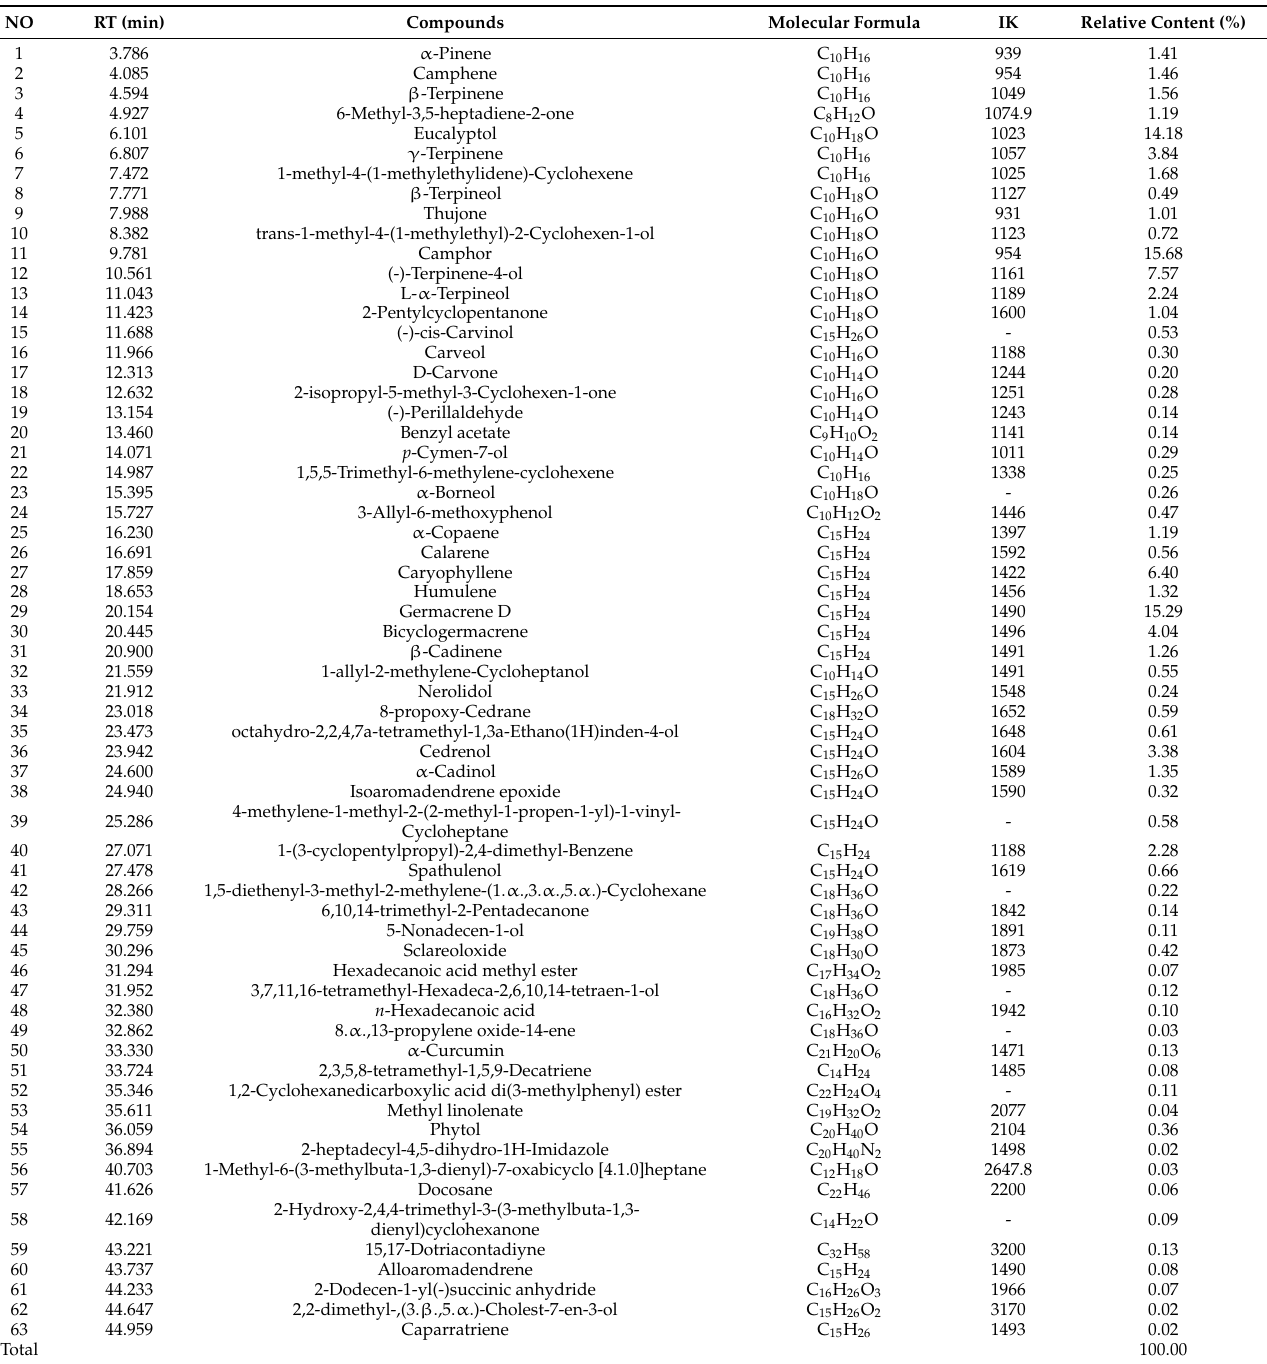
Table 1. The chemical composition of